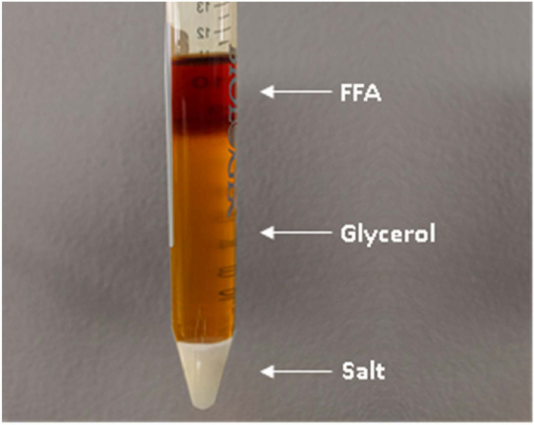
Figure 9. Acidified glycerol with three layers the FFA layer, glycerol layer, and salt residues. A portion of the fatty acids was converted into a water-soluble soap during the acidification process, while a portion of the methyl esters was dissolved or suspended in the glycerol solution. During the subsequent neutralization phase, free fatty acids and methyl esters interacted with excess NaOH to form soap, which was left in the glycerol residue. Therefore, some sodium phosphate (Na 3 PO 4 ) salts and water were produced as a result of NaOH neutralization with excess H 3 PO 4 . Neutralization was necessary because the PH of the crude glycerol had to be adjusted so that it was neither acidic nor basic, similar to pure glycerol. In consequence, the pH level was raised from 1 to 7. After the neutralization procedures, the generated water was removed by evaporating the solution at 110 ◦